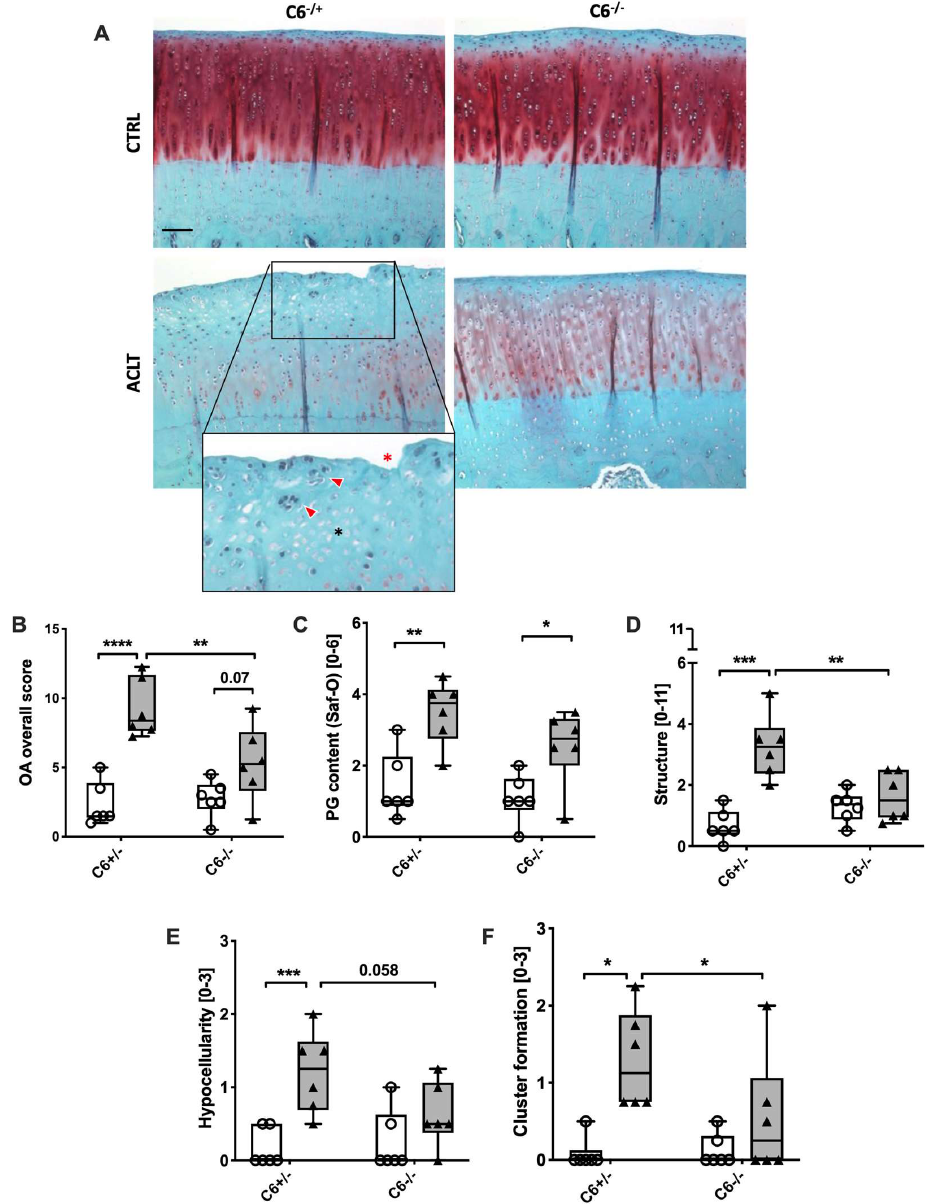
Figure 3. Histopathologic assessment of medial condyle sections. ( A ) Exemplary images of SafO- stained medial condyles of both experimental groups. Cell clusters are indicated by red arrowheads; black asterisk indicates hypocellular region; red asterisk indicates irregular surface; the black bar represents 50 µm. ( B–E ) Corresponding statistical analysis of the overall score and single parameters of the histopathological assessment: ( B ) overall score, ( C ) proteoglycan content/ SafO staining intensities, ( D ) structure/ surface integrity, ( E ) hypocellularity, and ( F ) cluster formation. Data are charted as box plots with median and whiskers min to max; white boxes= control joint, grey boxes= ACLT-operated joints. Statistically significant differences between groups ( n = 6 each) were depicted as: *: p ≤ 0.05, **: p ≤ 0.01, and ***: p ≤ 0.001, ****: p ≤ 0.0001.